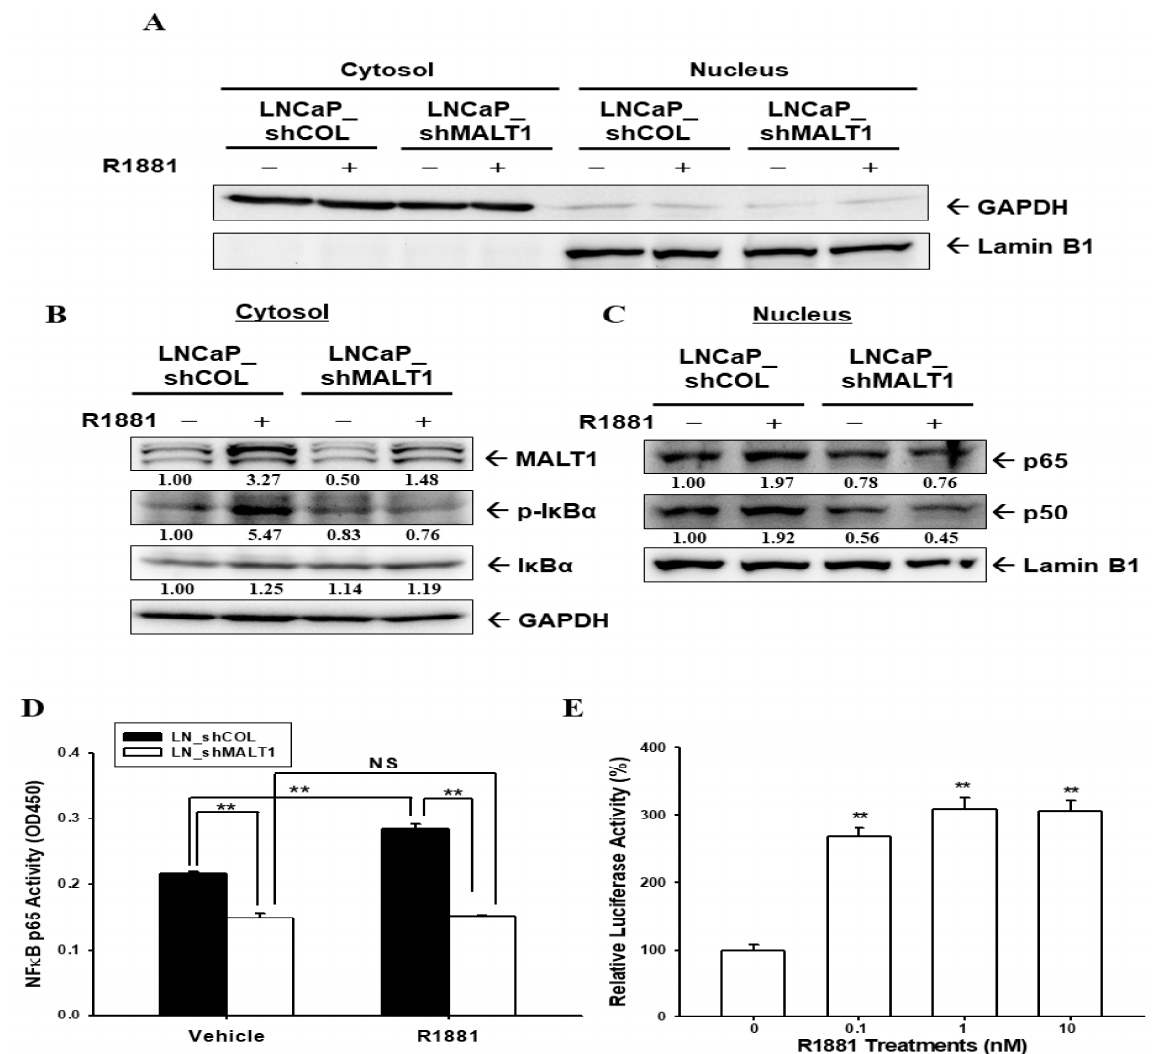
Figure 3. Effect of androgen on NF- κ B signaling is dependent on MALT1 in androgen-dependent LNCaP prostate cancer cells. The LN_shCOL and LN_shMALT1 cells were treated with or without 10 nM of R1881 for 24 h. ( A ) The expression of GAPDH in cytosol and Lamin B1 in the nucleus were determined by immunoblotting after the separation of nuclear and cytoplasmic fractions as indicated. The expression of MALT1, I κ B α , phospho-I κ B α , and GAPDH in the cytosol fraction ( B ), as well as p65, p50, and Lamin B1 in the nuclear fraction ( C ), were determined by immunoblotting. The numbers indicate the ratio of target proteins/GAPDH or Lamin B1 in relation to vehicle treatment. ( D ) The NF- κ B (p65)-binding activity in the LN_shCOL and LN_shMALT1 cells after treatment with R1881 for 18 h. ( E ) The reporter activity of the MALT1 reporter vector was treated with various concentrations of R1881 as indicated for 24 h in the 22Rv1 cells. The data are presented as mean percentages ( ± SE, n = 6) relative to the control vehicle-treated group. ** p < 0.01, NS represents no